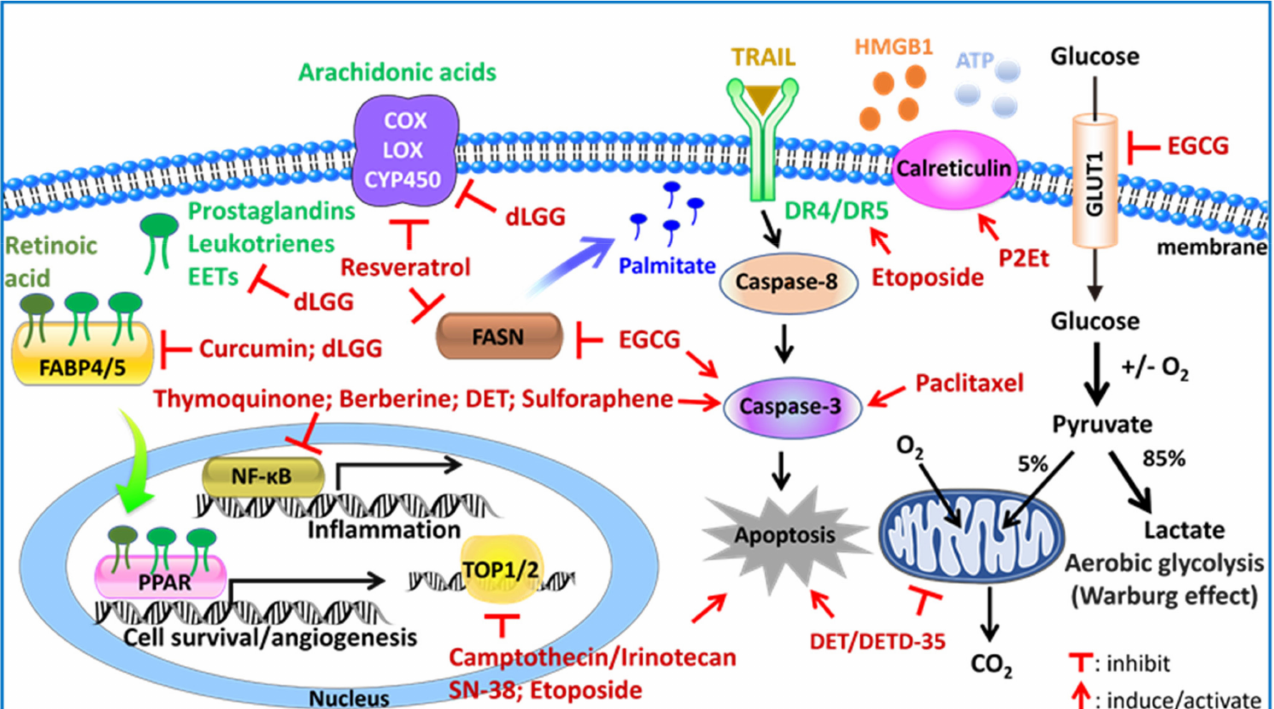
Figure 1. A summary of the effects and mechanisms of selected phytocompounds/extracts on the regulation of TNBC cell growth, apoptosis, and metabolism. EGCG decreases GLUT1 expression, glucose uptake, and lactic acid level and suppresses glycolytic enzymes involved in the Warburg effect. EGCG also inhibits FASN and FASN-mediated drug resistance through the overproduction of palmitate. By down-regulating FASN expression, resveratrol reduces the cell survival and mammosphere formation of BCSCs. Arachidonic acids can be metabolized by COXs, LOXs, and CYP450 epoxygenases to produce prostaglandins, leukotrienes, and EETs, respectively. Resveratrol prevents DMBA-induced mammary carcinogenesis by blocking 5-LOX or by suppressing the DMBA-induced COX-2 and MMP-9 expression in the breast tumor. Nuclear translocation of FABP4 and FABP5 mediated by lipid ligands, such as EETs, upregulates nuclear expression of PPAR and the transcription of PPAR-regulated genes. By suppressing the expression levels of FABP5 and PPAR β / δ , curcumin prevents the delivery of retinoic acid to PPAR β / δ and suppresses retinoic acid-induced PPAR β / δ target genes. A phytogalactolipid, dLGG, effectively attenuates TNBC recurrence and lung metastasis through downregulation of FABP4, FABP5, PPAR γ , and EETs. Camptothecin, irinotecan, SN-38, and etoposides are TPO1/2 inhibitors. Etoposide enhances DR5 expression, promoting TRAIL-induced apoptosis. Thymoquinone, berberine, DET, and sulforaphane inhibit NF- κ B activation, showing anti-inflammatory activities. Paclitaxel and other phytocompounds increase caspase-3 activity. P2Et can trigger immunogenic cell death, inducing the release of HMGB1 and ATP and expression of